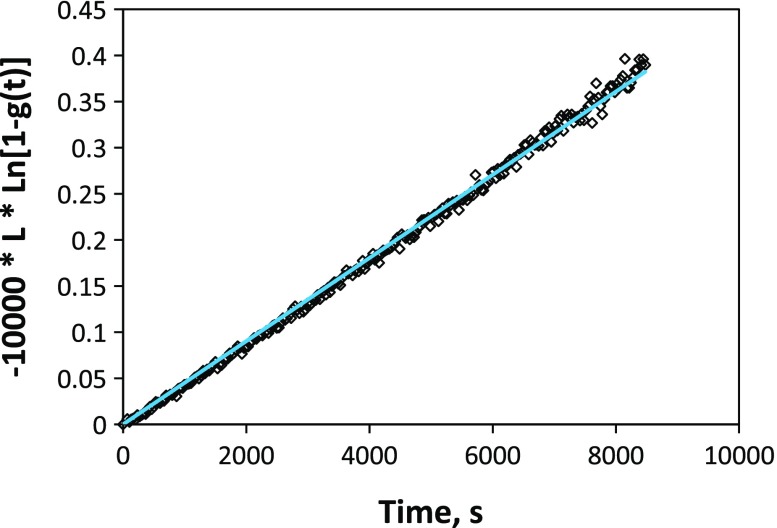
Fit by Equation (2) for surface exchange-limited kinetics, demonstrating the expected linear behavior and that was used to extract k
chem from the slope. Film thickness was ~200 nm.